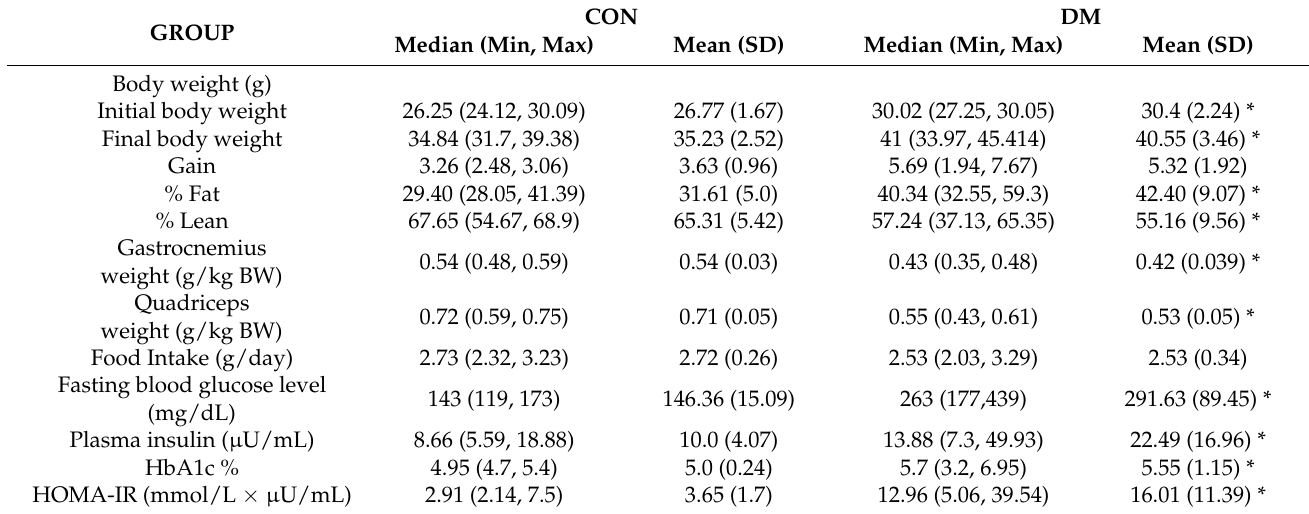
Table 1. Body composition, food intake, and glycemic regulation in T2DM